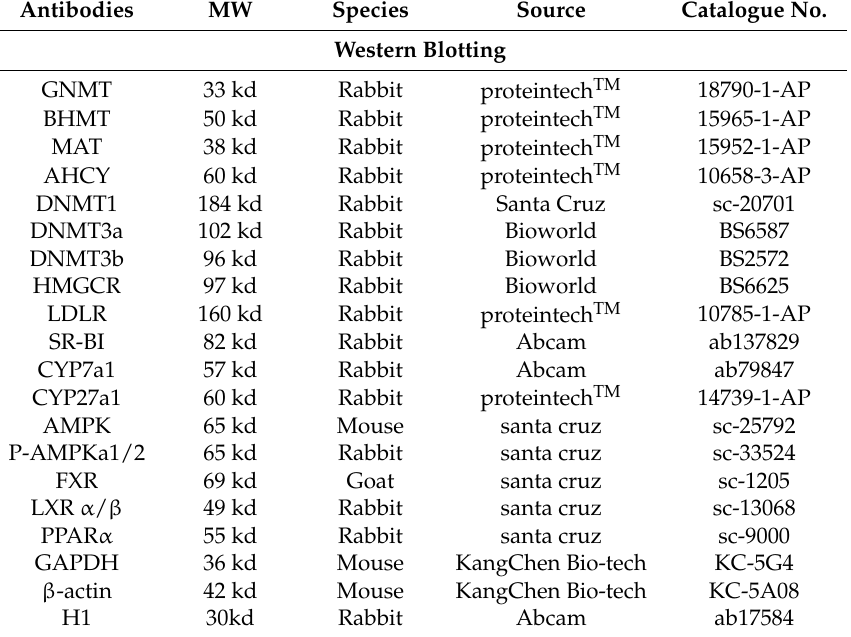
Table 3. Antibodies for this